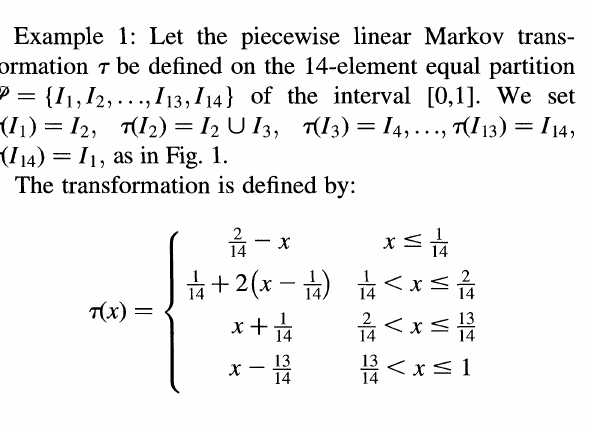
Example 1: Let the piecewise linear Markov